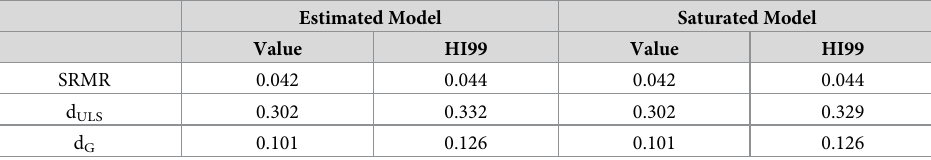
Table 3. Test of model